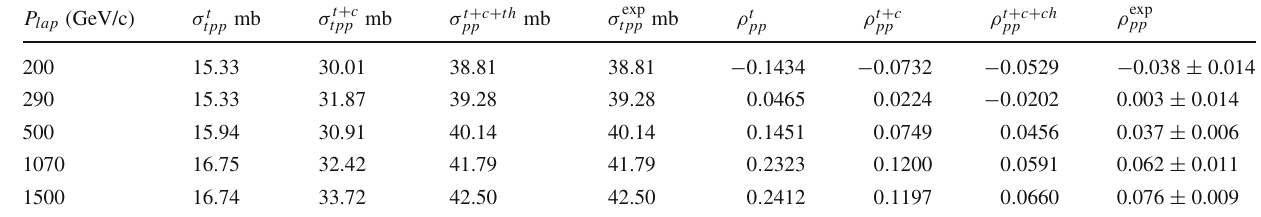
Table 3 Total cross section with (two-quark force, σ t tpp ), with (two- quark force +pion cloud, σ t + c tpp ) and with (two-quark force +pion cloud+three-quark force, σ t + c + th tpp ). The ratio of real to imagi- nary parts of p–p elastic scattering amplitude in the forward direc-